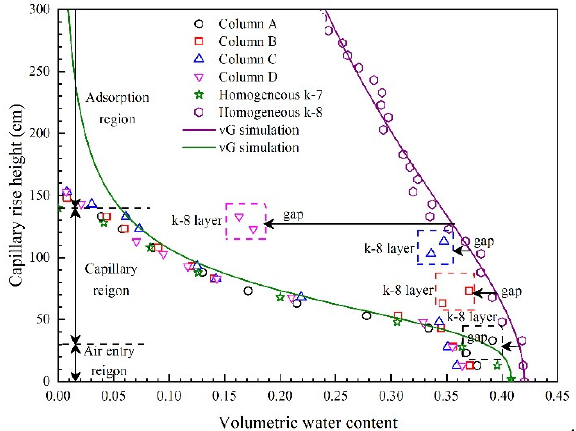
Figure 6. Water content distribution in the layered soil profile after the water capillary rise for 240 days.